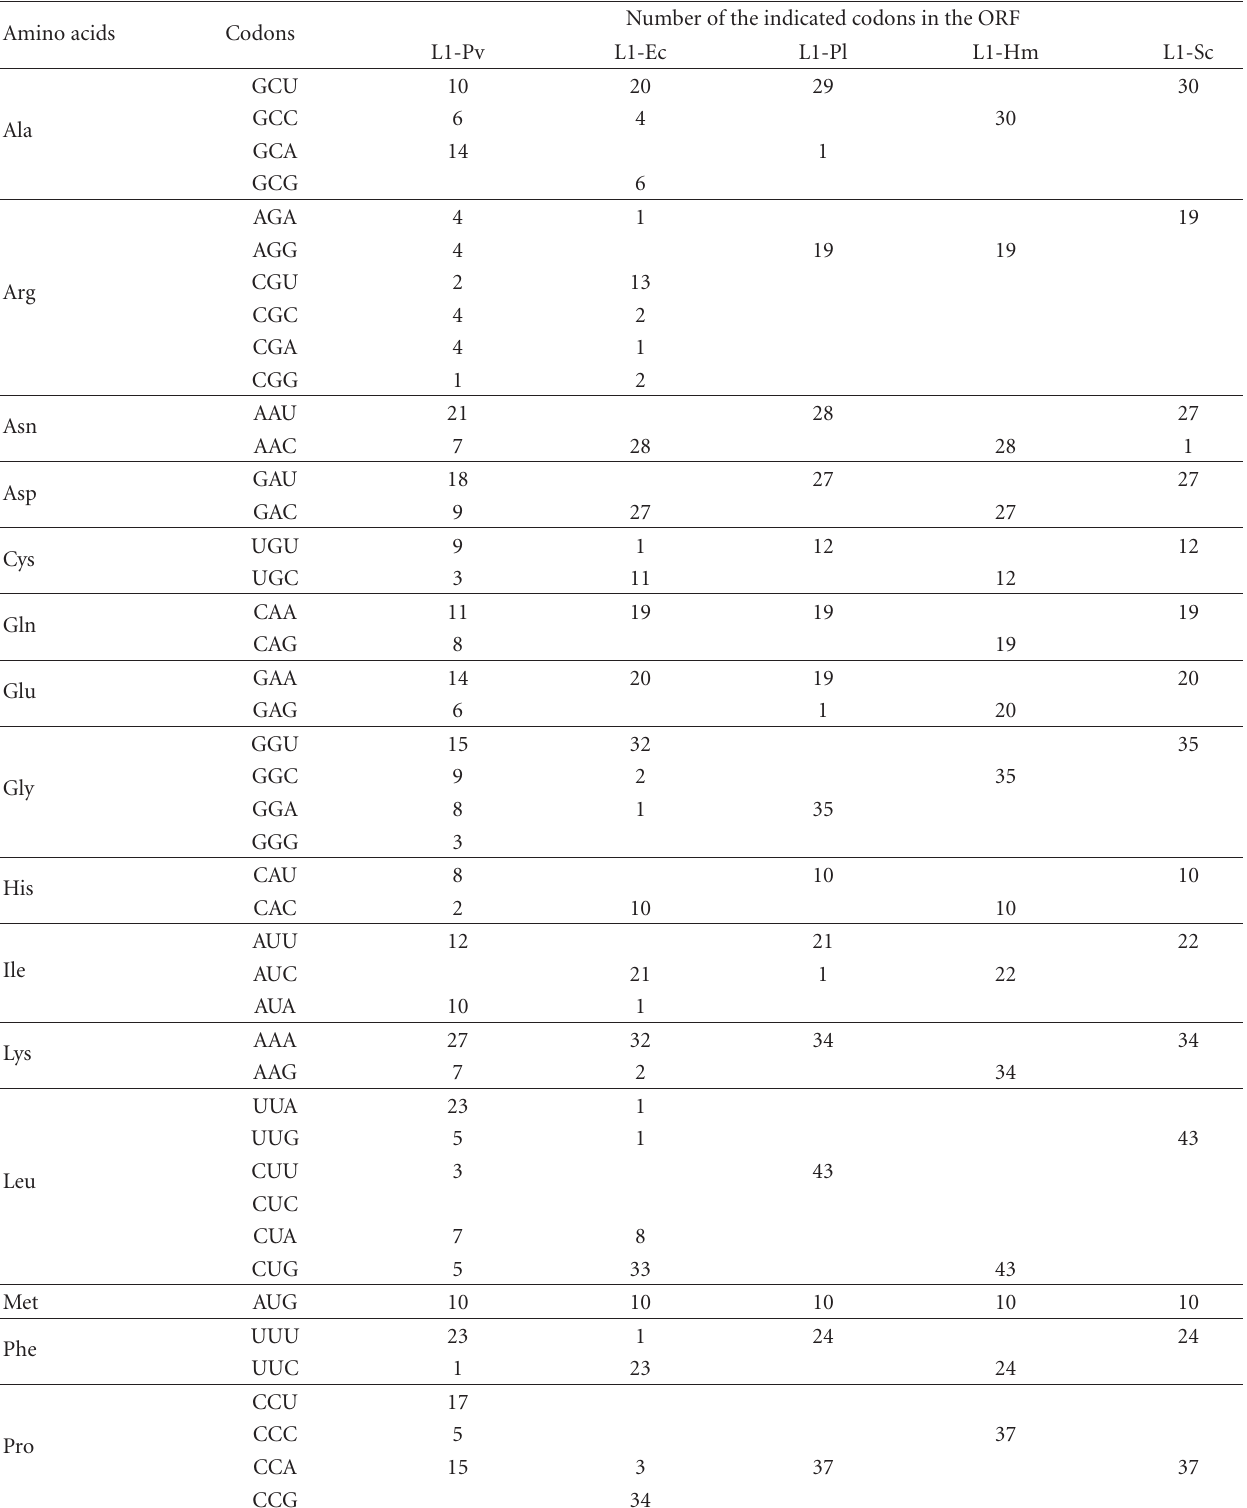
Table 1: Codon usage in HPV-16 L1-Sc, L1-Pl, L1-Ec, Li, L1-Hm, and L1-Pv